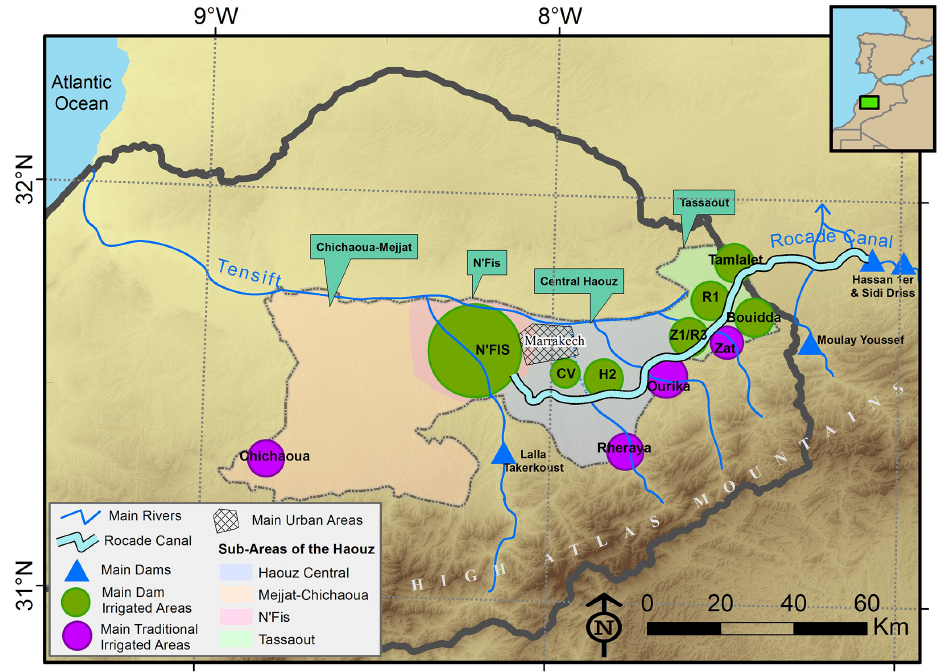
Figure 1. The Haouz-Mejjat aquifer is located within the Tensift watershed (gray) and separated into four subareas. The most important traditional and dam irrigated areas are shown on the map. The N’Fis area is a mix of traditional and modern irrigation. All of these areas also use groundwater, but outside them, the irrigated areas (private irrigation) rely exclusively on